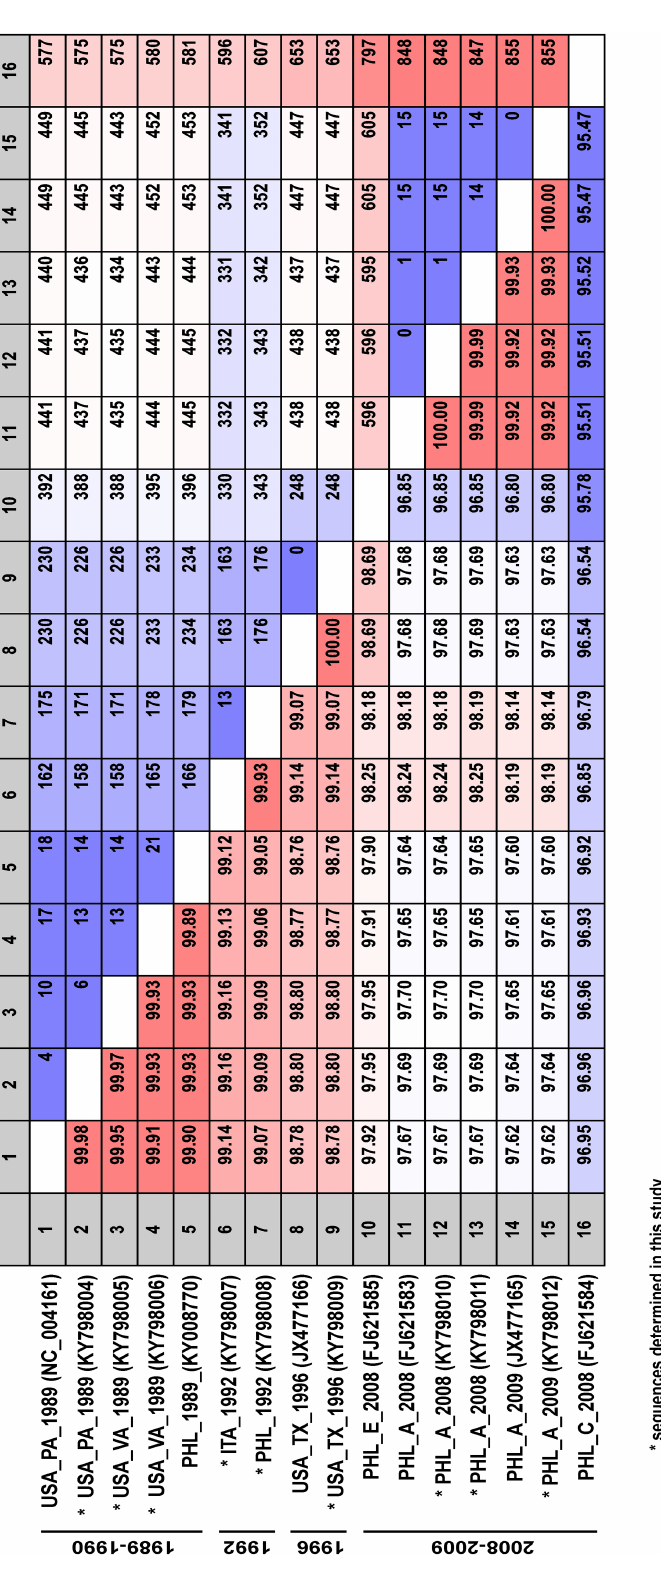
Fig 1. Sequence comparison of full-length viral genomes of representative RESTV isolates. Sequence identity (%) is indicatedin the lower diagonalhalf, whilethe number of differing residues is indicatedin the upper diagonalhalf. Asterisks indicate the 9 sequencesdetermined in this